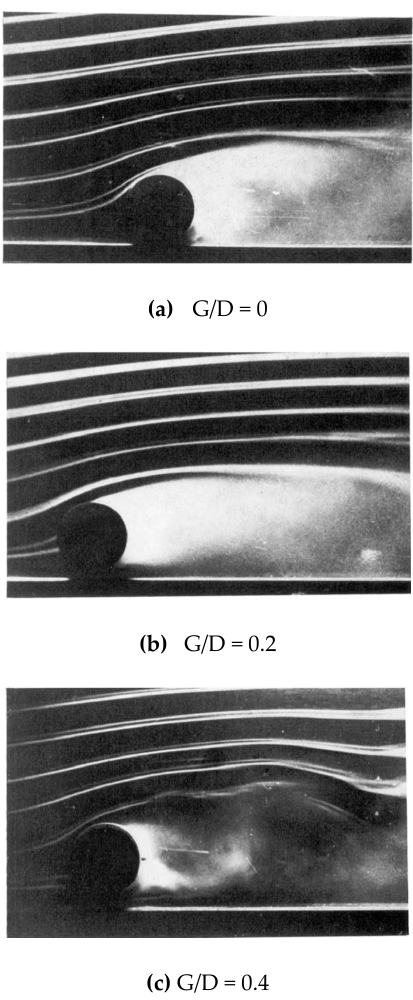
Figure 3. The flow pattern of a cylinder near a wall, G/D = 0; G/D = 0,2; G/D = 0.4, copyright [12]. However, their data appears to reveal an upward trend in the recorded values of the Strouhal number of approximately 5% at a gap of 0.75 diameters. It is argued that this effect is caused by a reduction of the scale of the vortex formation region due to the proximity of the wall, and that when the shear layers are brought closer together, their interaction is facilitated, and the shedding period is shortened [17]. Variation of vortex shed-ding frequency as a function of wall distance from the cylinder are plotted in Figure 4, which shows that the shedding frequency gradually increased as the gap decreased. A 10% increase of shedding frequency is expected when the gap is very